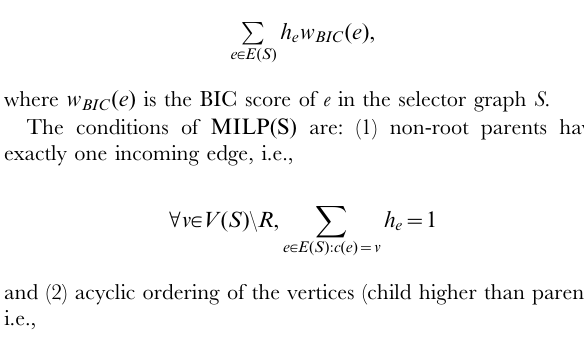
Figure 2. Percentage of recovered edges when data is generated with monotone, semi-monotone, and general networks and learned with the same method for 2 and 3-bounded graphs. The error bars show 1 standard deviation.